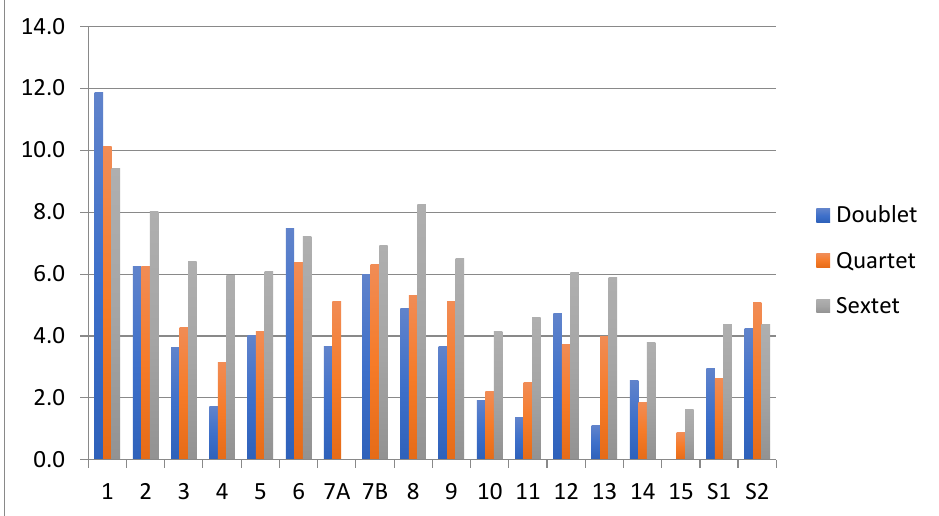
Figure 3. Gibbs energy profile for OsC 6 H 6 cation (eV).